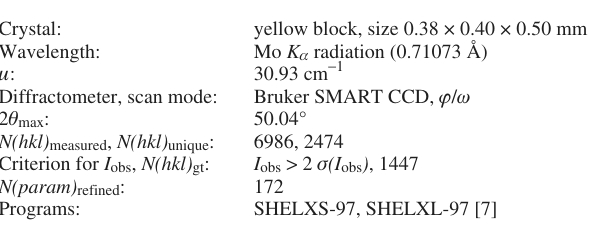
Table 1. Data collection and handling.